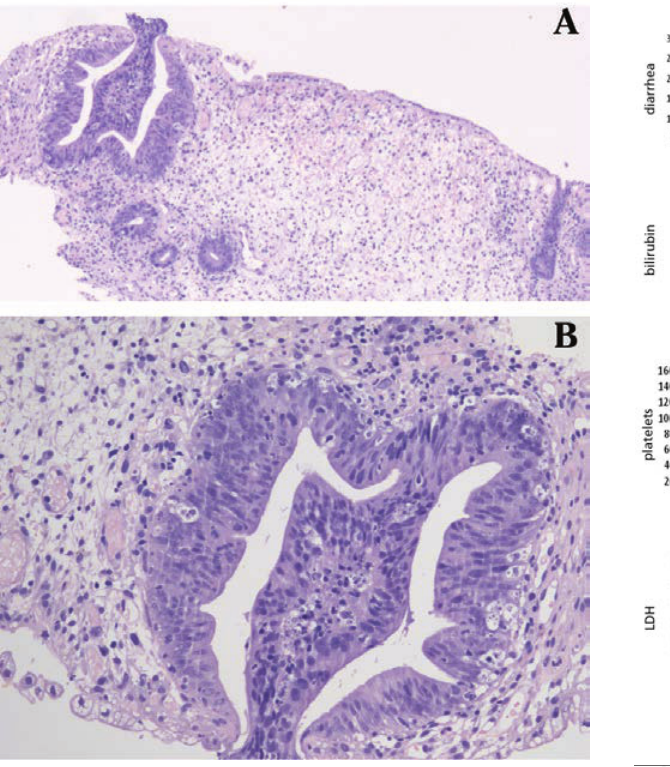
Figure 2. Levels of diarrhea (mL), bilirubin (mg/dL), platelets (×10 9 ) and LDH (IU/dL) after